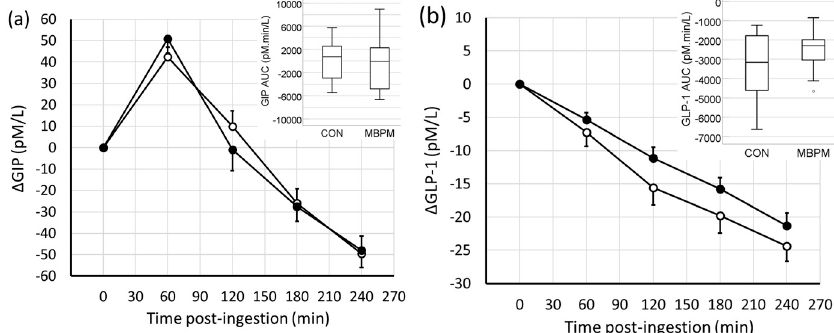
Figure 3. Temporal change in enterogastric peptides following ingestion of CON (open circles) and MBPM (filled circles); ( a ) GIP and ( b ) GLP-1. Data are the mean and SEM, n = 13. Insert denotes the area under the curve, AUC 0-240.